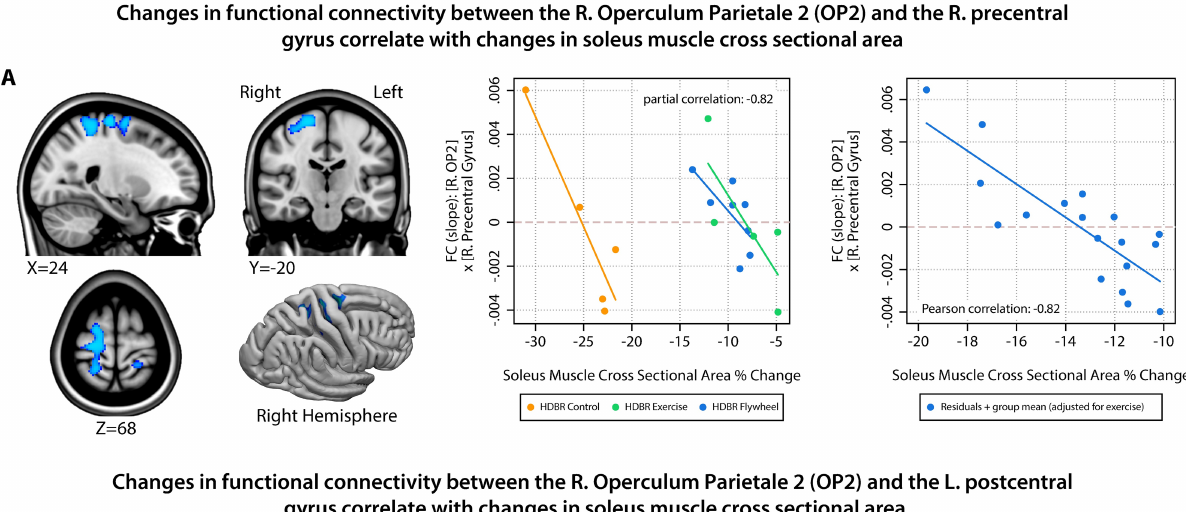
PLOS ONE | https://doi.org/10.1371/journal.pone.0205515 October 11, 2018 14 /